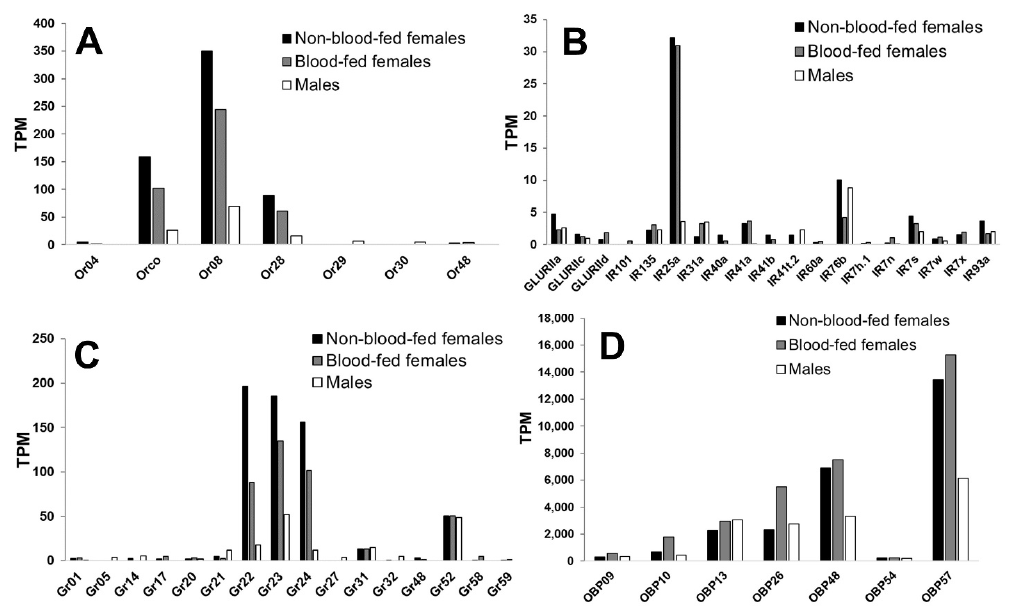
Figure 1. Transcript abundance of chemosensory genes. Transcript abundance of the ( A ) odorant receptors, ( B ) ionotropic receptors, ( C ) gustatory receptors, and ( D ) odorant-binding proteins in the mouthparts of An. stephensi non-blood-fed females (black bars), 12-h blood-fed females (gray bars), and males (white bars).